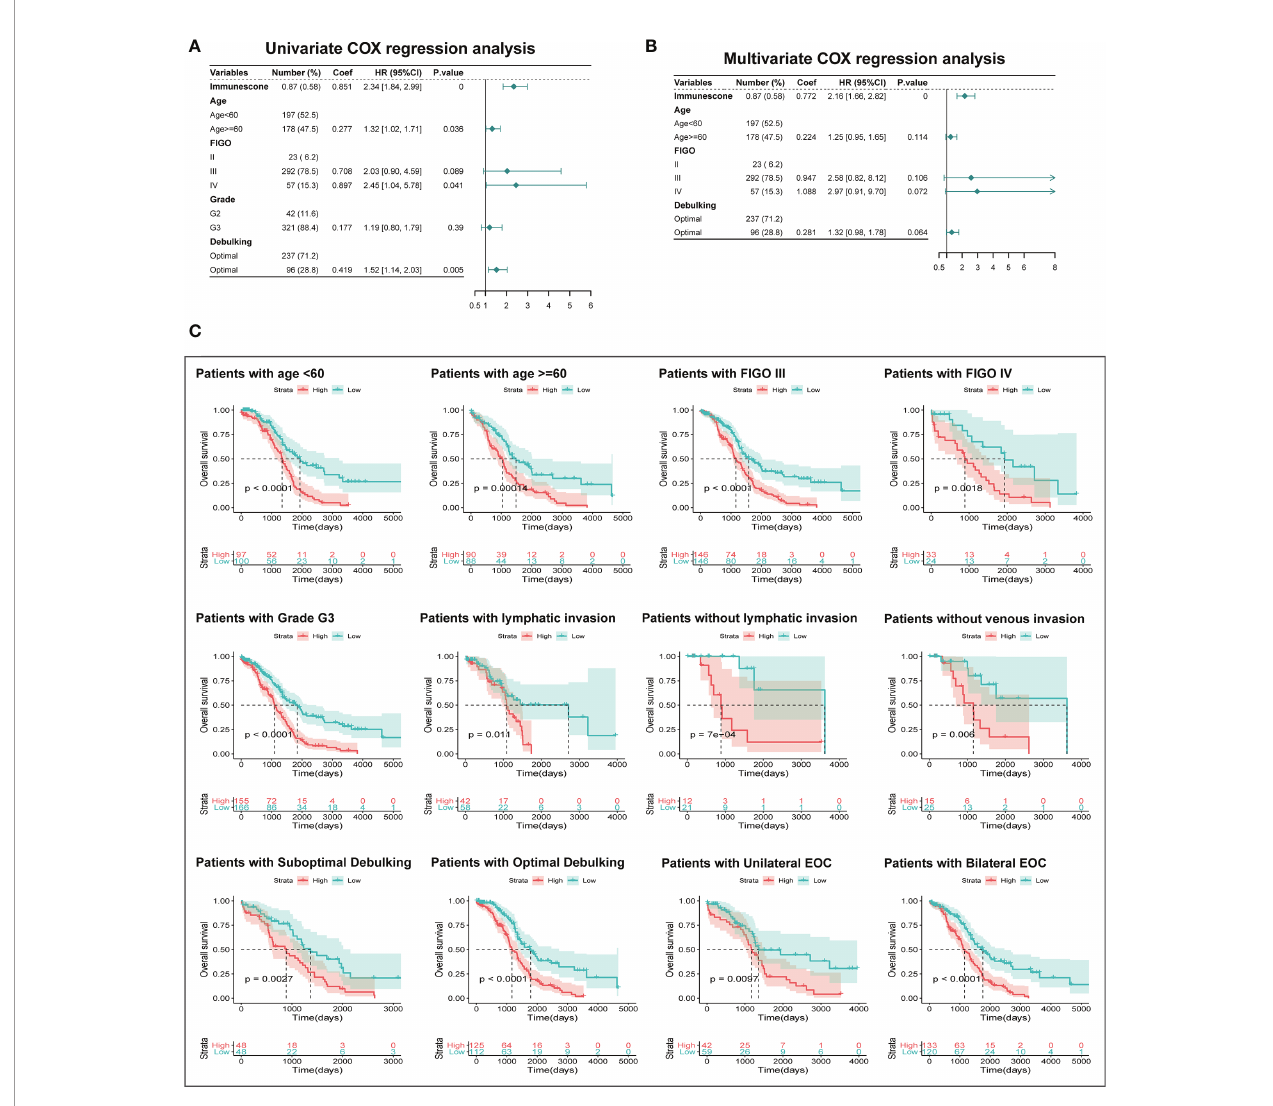
FIGURE 7 | Independent Prognostic Signi fi cance of TIMErisk and Clinical Strati fi cation Analysis. (A) Univariate Cox regression analysis of the TIMErisk and clinical characteristics for the independent prognostic signi fi cance in the TCGA cohort. (B) Multivariate Cox regression analysis of the TIMErisk and clinical characteristics for the independent prognostic signi fi cance in the TCGA cohort. (C) Kaplan – Meier survival curves of patients in the low- and high-risk groups within clinically strati fi ed